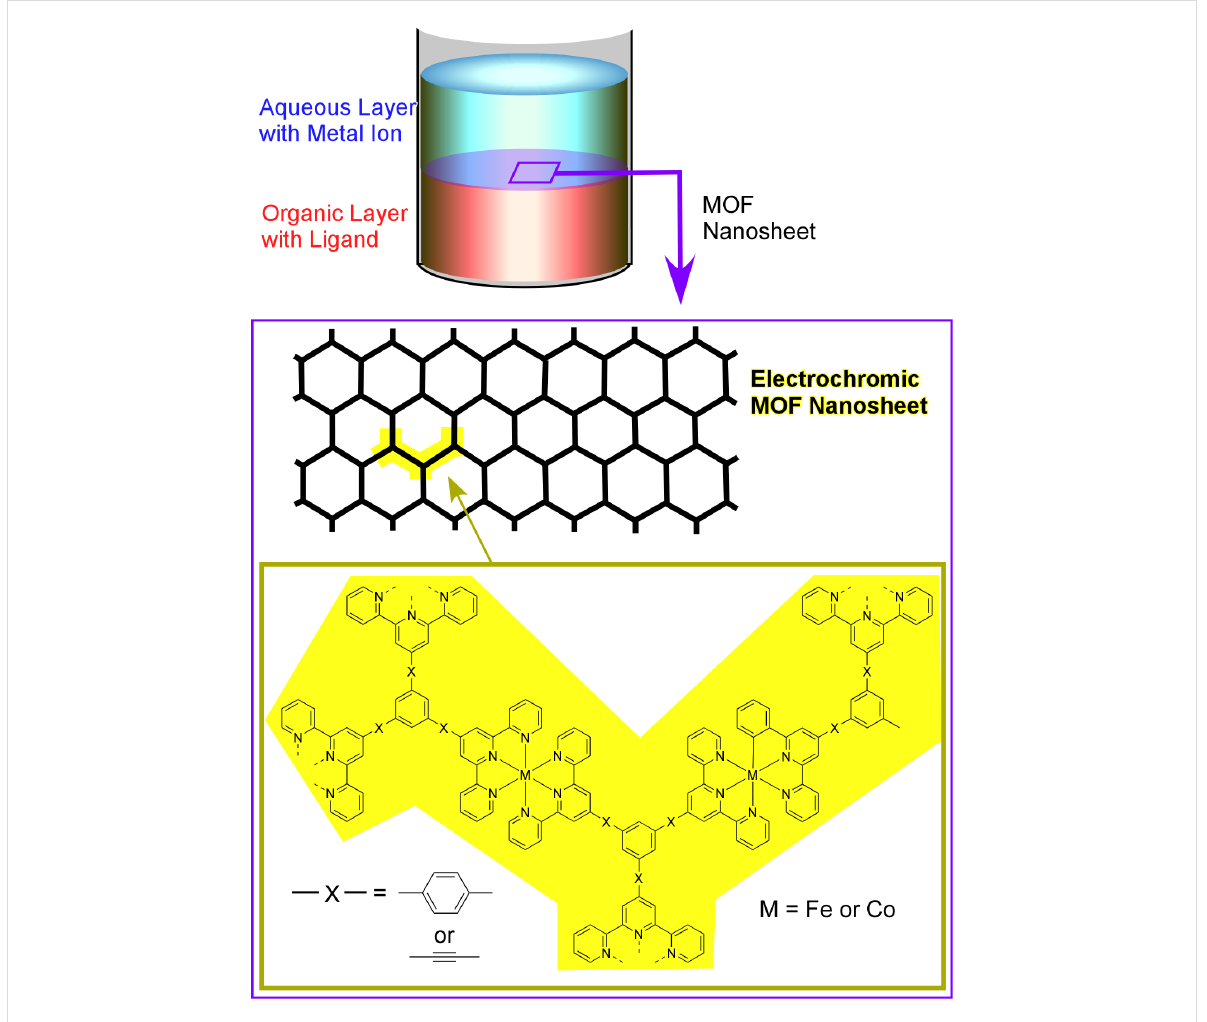
Figure 11: Electrochromic bis(terpyridine)metal complex MOF nanosheets formed through coordination of terpyridine moieties to either cobalt or iron ions. The synthesized films change their colour depending on the oxidation levels of the cobalt and iron ions.